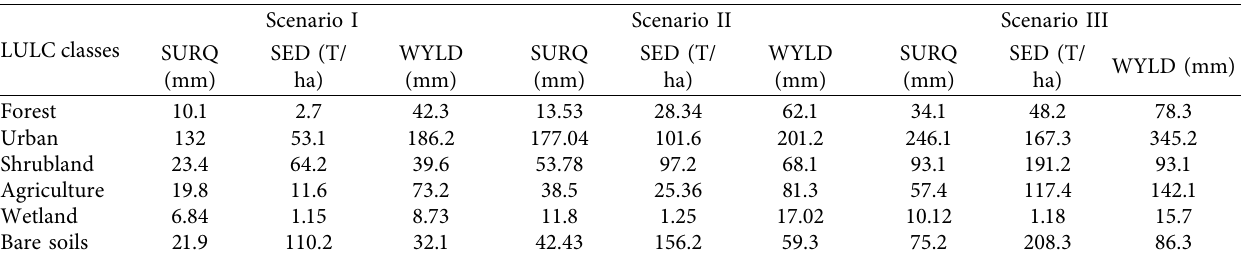
Table 13: Contribution of each LULC to cause surface runof, water yield, and sediment yield. Scenario LULC classes